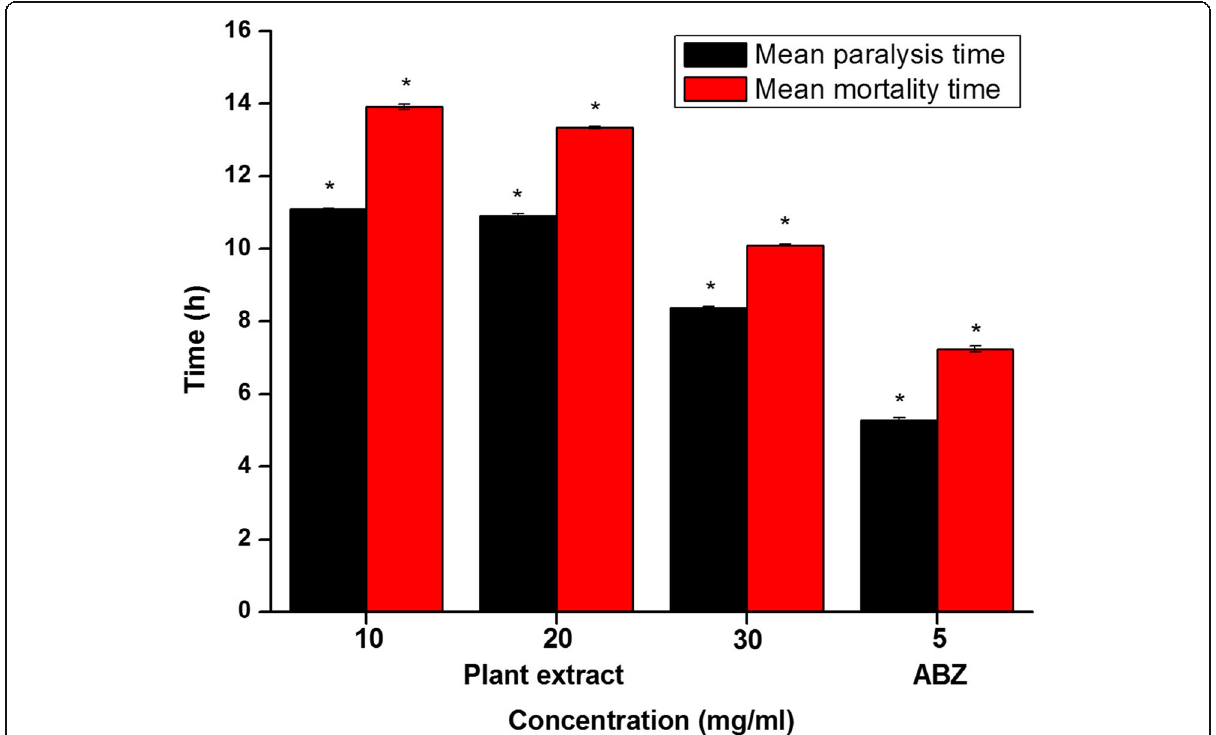
Fig. 3 In vitro anthelmintic efficacy of C. compressus methanolic root extract against S. obvelata . Data is expressed as mean ± SEM. * p < 0.0001 compared with control group, Students ’ t test